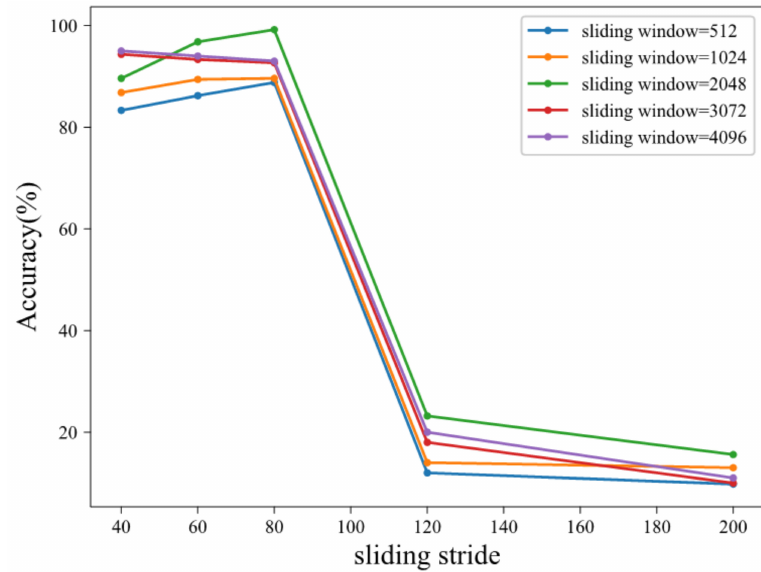
Figure 5. Sliding window length and stride parameter selection.